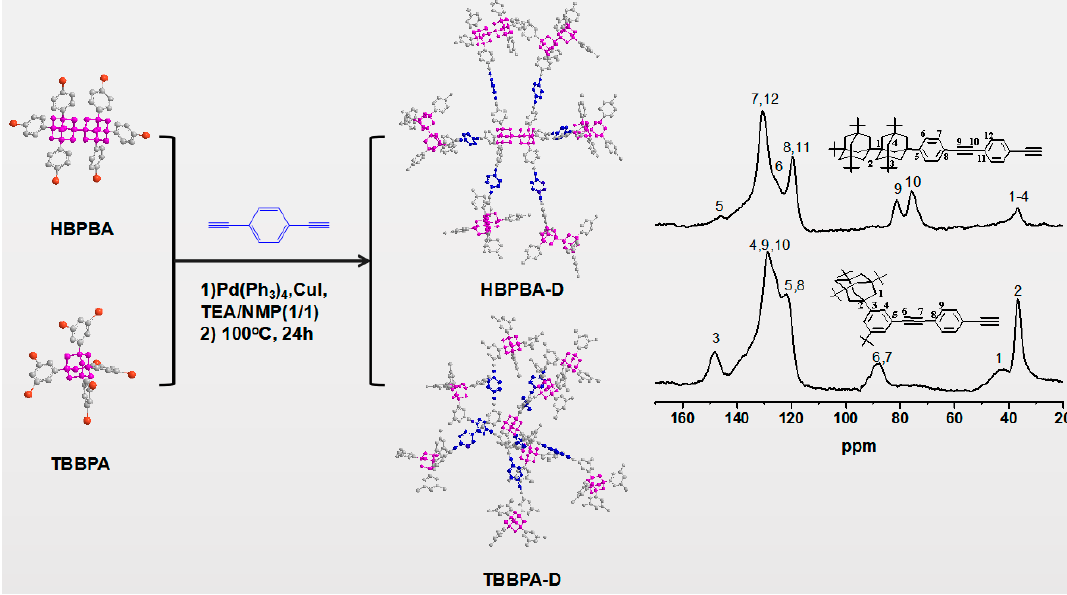
Figure 1. Synthetic route to HBPBA-D and TBBPA-D and 13 C CP/MAS NMR spectra.